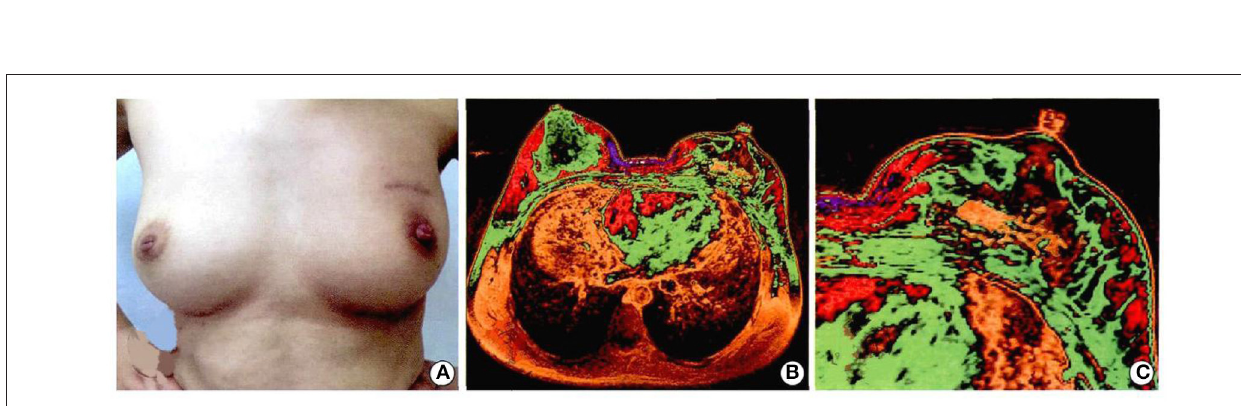
Frontiers in Surgery |